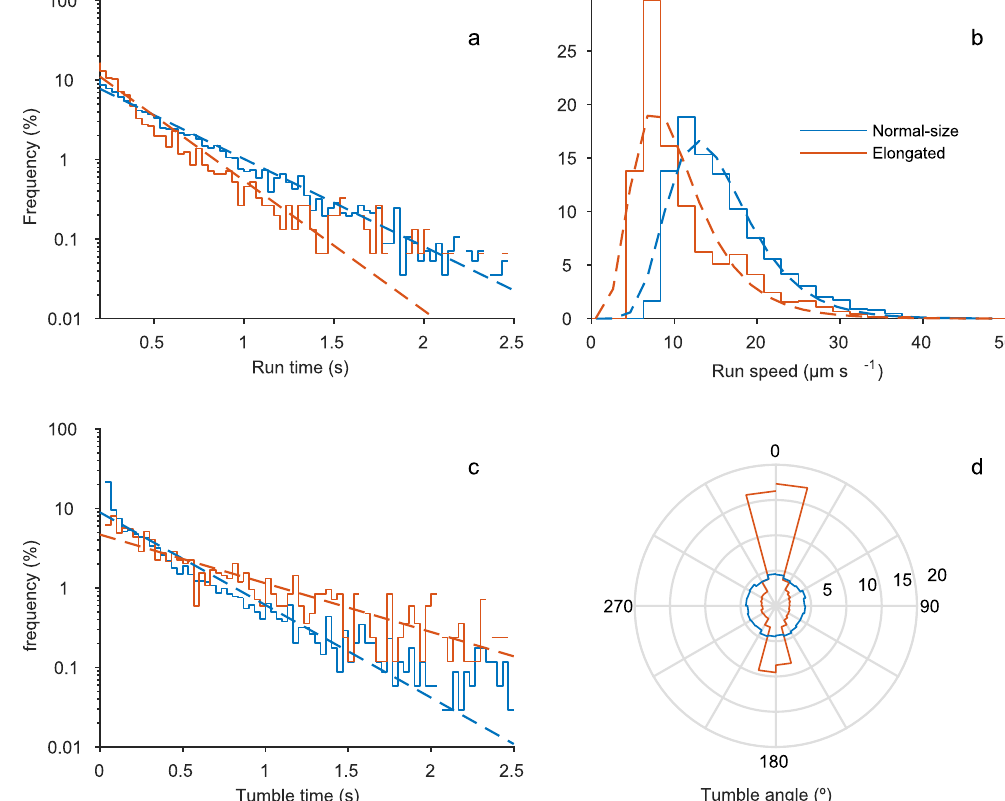
Figure 1. Frequency distributions of ( a ) run times; ( b ) run speed; ( c ) tumble times; and ( d ) tumble angles, for normal-size bacteria (length = 1.7 ± 0.1 µ m, in blue) and an example subset of elongated bacteria (length = 10 ± 1 µ m, in red). Dashed lines in a and c are the maximum likelihood estimations of exponential distributions. Dashed lines in b are the maximum likelihood estimations of lognormal distributions. Distributions are built from 5687 runs and 4156 tumbles from normal-size cells, and 1521 runs and 970 tumbles from elongated